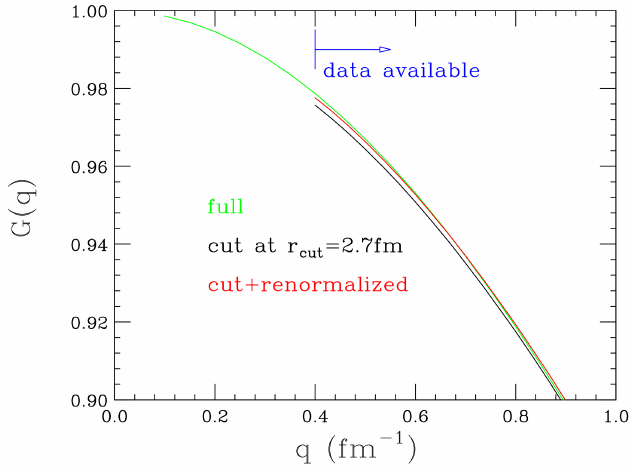
Figure 3. Form factor corresponding to (1) full density (green), (2) truncated density (black) and (3) truncated density, renormalized to best agree with (1)